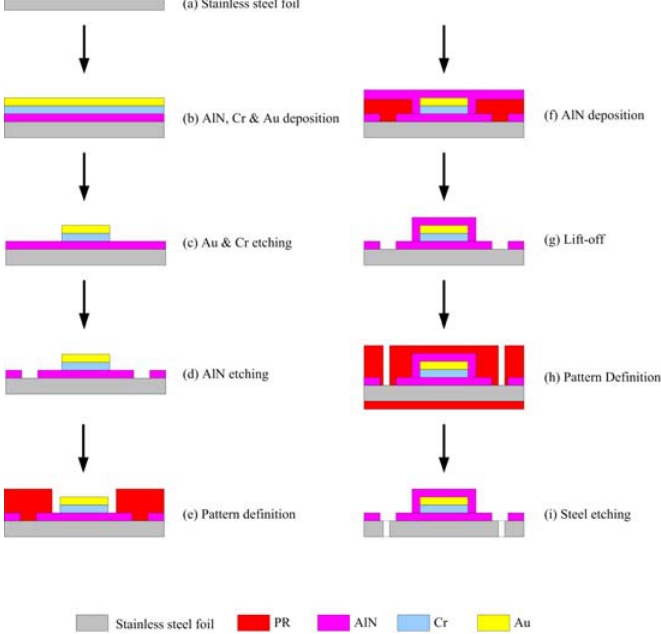
Figure 3. Fabrication of flexible micro temperature